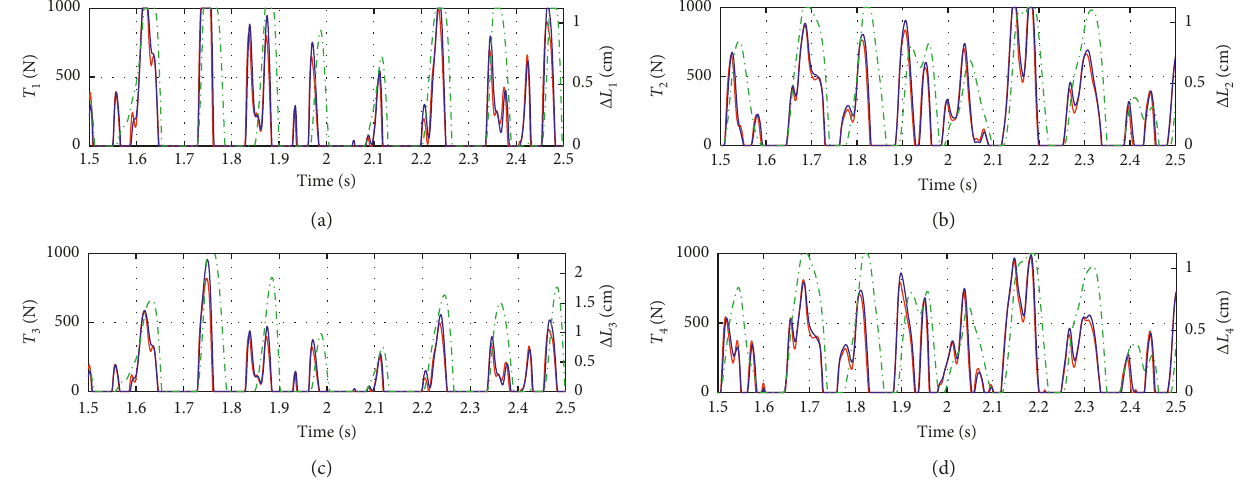
i without considering the inertial constraint in